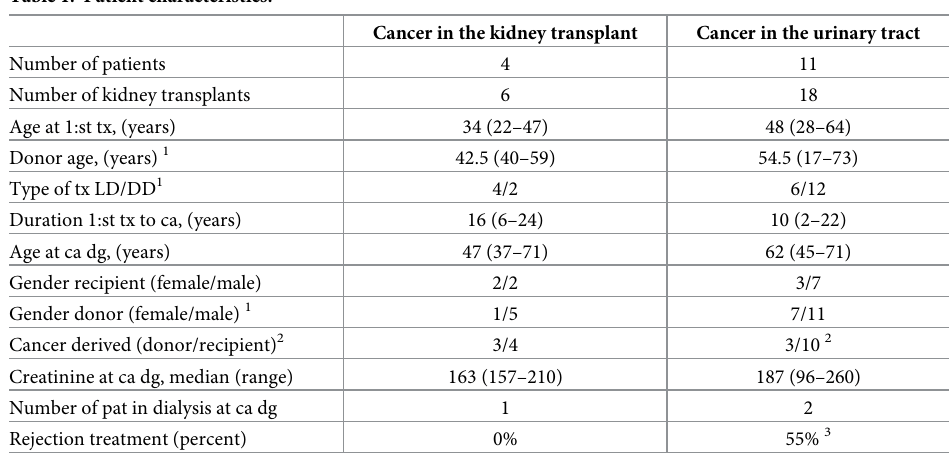
Table 1. Patient